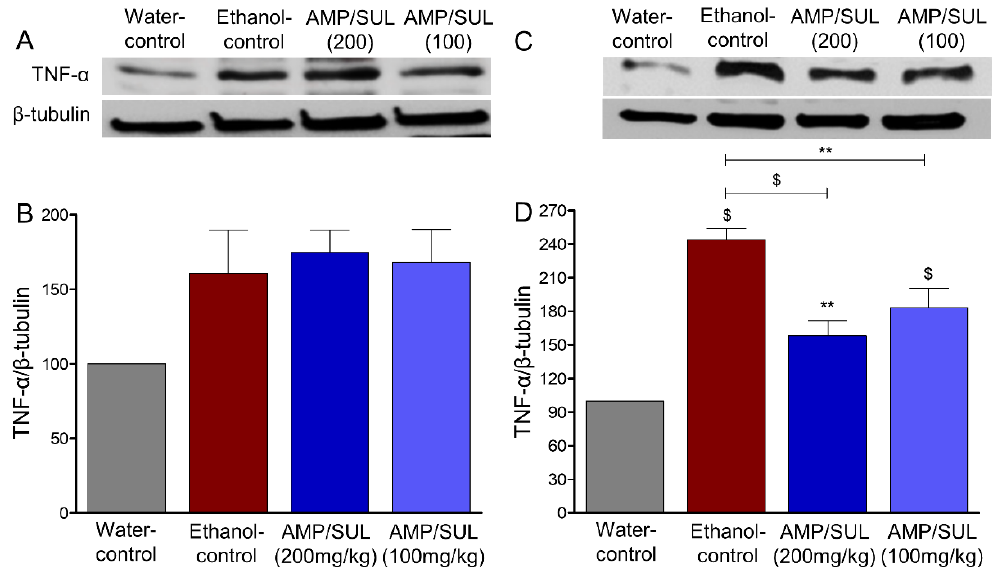
Figure 5. E ff ects of AMP / SUL treatments (100 mg / kg and 200 mg / kg, i.p.) for five days on Figure 5. Effects of AMP/SUL treatments (100 mg/kg and 200 mg/kg, i.p.) for five days on the expression of TNF- α in the AcbCo and AcbSh. ( A ) Immunoblot of TNF- α and β -tubulin in the AcbCo.